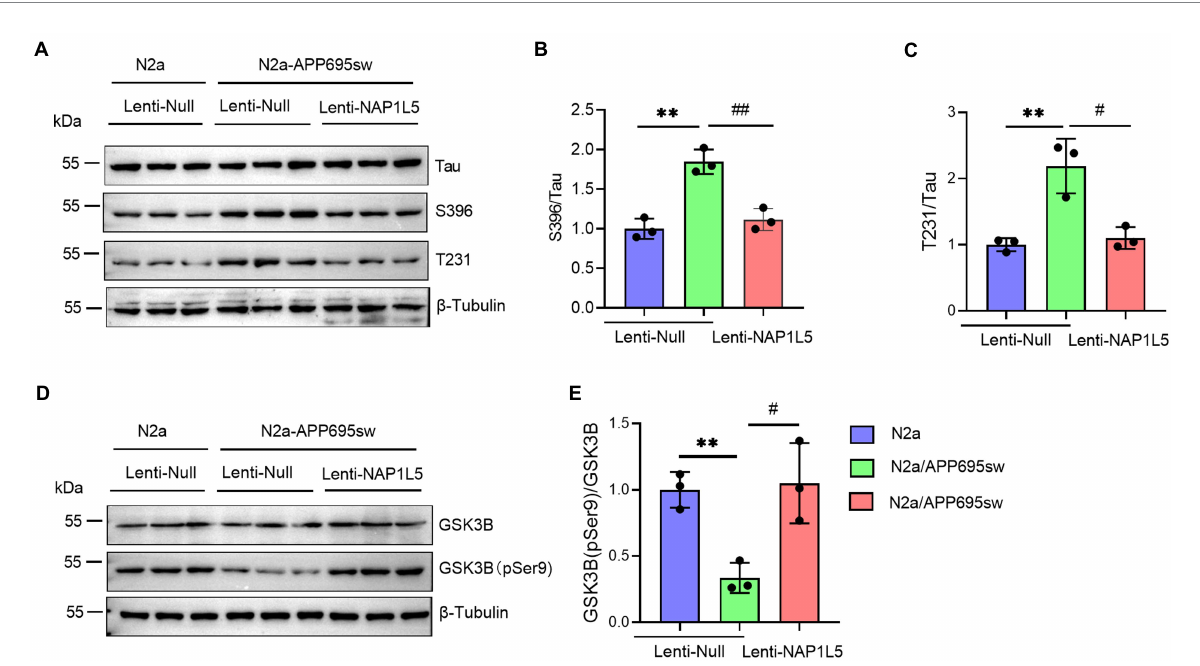
FIGURE 3 NAP1L5 overexpression abrogated the hyperphosphorylation of Tau but enhanced the phosphorylation of GSK3B at serine 9 in N2a-APP695sw cells. (A–E) , N2a and N2a-APP695sw cells were stably infected with lenti-Null and lenti-NAP1L5. The Tau and phosphorylated Tau protein levels were detected using Western blotting (A) , and then quantified (B,C) . The GSK3B and phosphorylated GSK3B at serine 9 (GSK3B (pSer9)) levels were measured using Western blotting (D) , and then quantified (E) . Data are presented as mean ± SD, n = 3. ∗∗ p < 0.01 for N2a-APP695sw (lenti-Null)